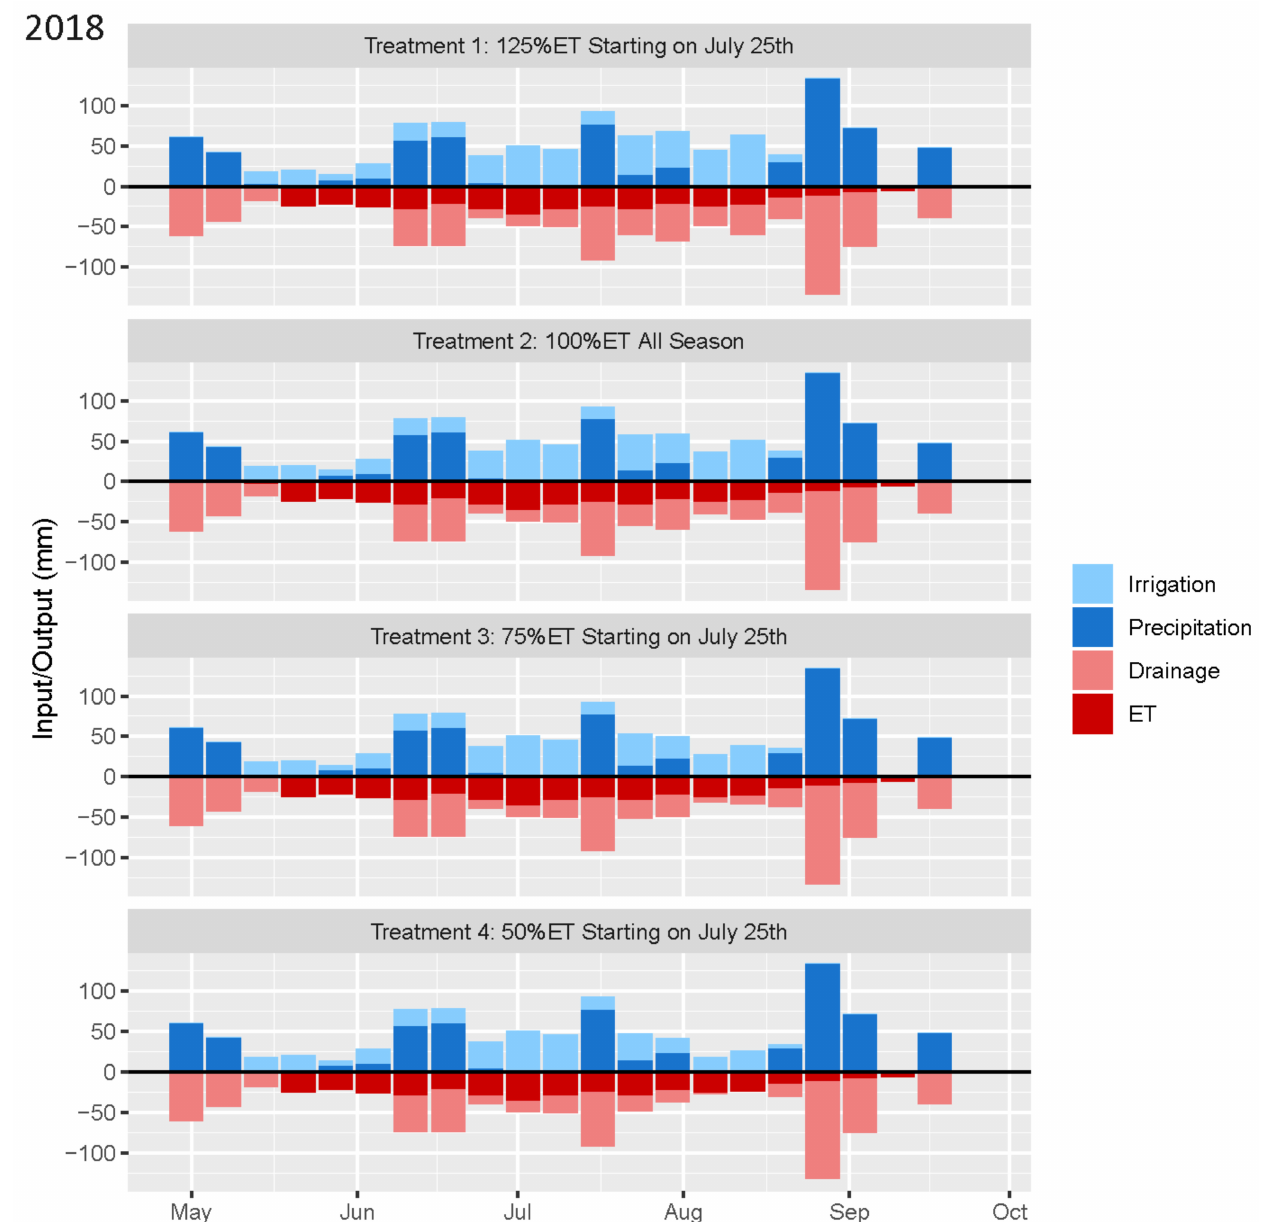
Figure 5. Weekly soil water balance values under each irrigation treatment in